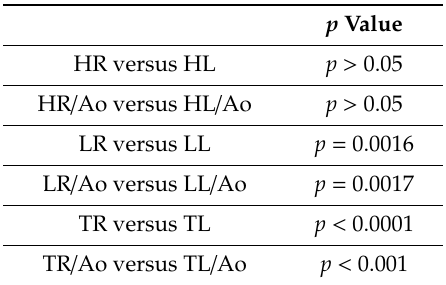
Table 2. Results of the paired-sample Wilcoxon test. HR and HL, height of right and left medial iliac lymph nodes. LR and LL, length of right and left medial iliac lymph nodes. TR and TL, thickness of right and left medial iliac lymph nodes. Ao, aortic diameter (in longitudinal scan).